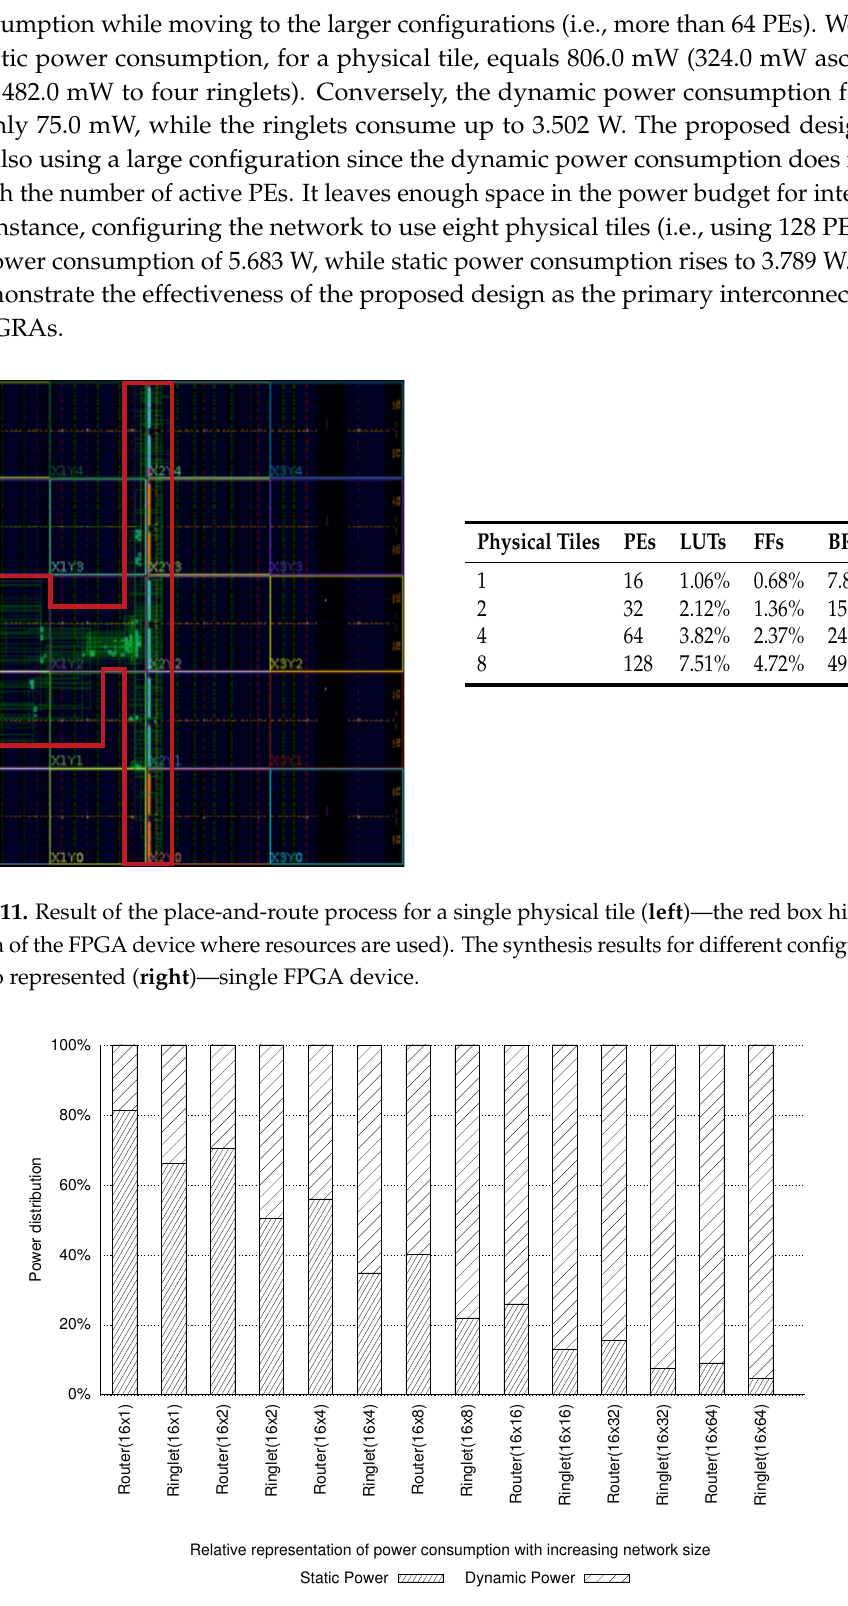
Figure 12. Static and dynamic components of the SDNoC power